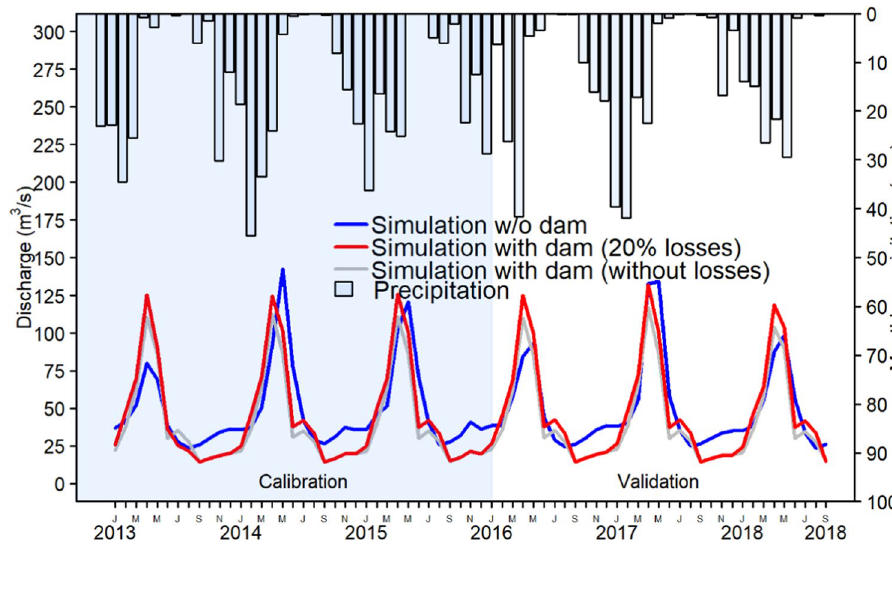
Fig. 5 Resulting hydrographs from subbasin 7 with (red) and without (blue) dam inclusion in subbasin